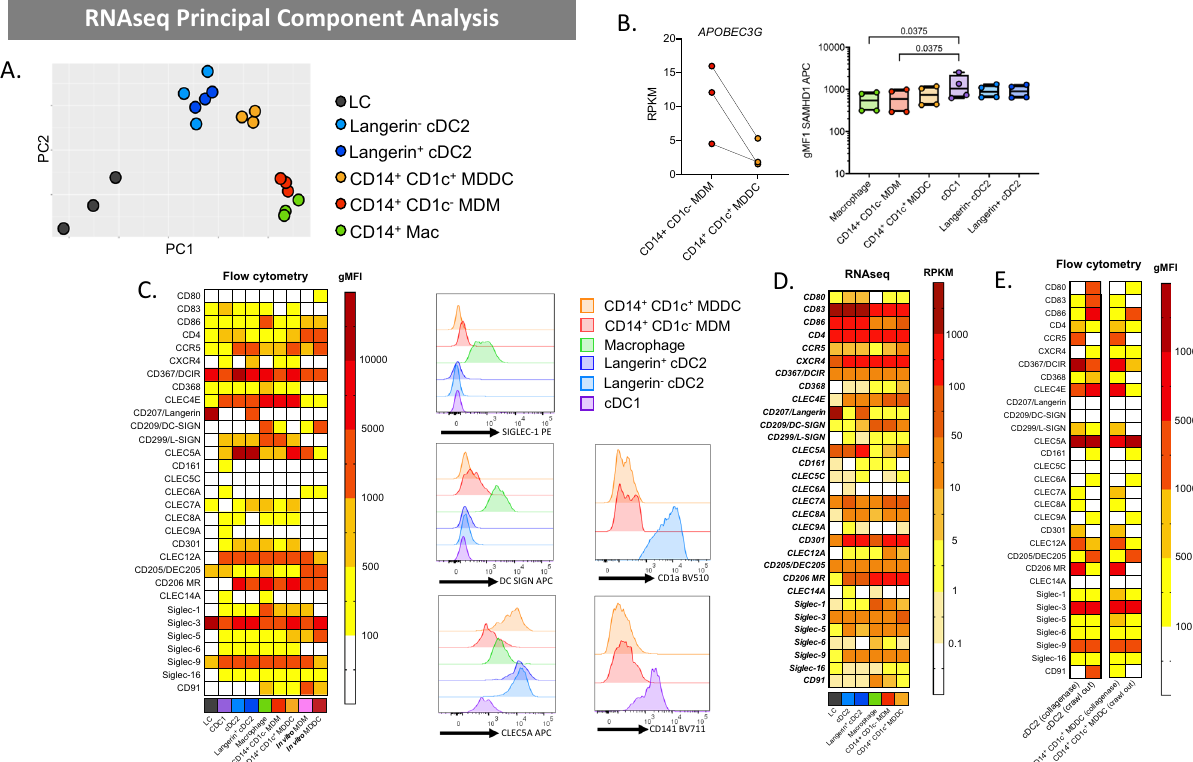
Fig. 3 Genotypic and phenotypic pro fi ling of epidermal and dermal human abdominal skin mononuclear phagocytes. A Dermal macrophages, cDC2 (langerin − and langerin + ), CD14 + CD1c + cells and CD14 + CD1c − cells as well as epidermal Langerhans cells were liberated from n = 3 abdominal skin donors and FACS isolated for RNAsequencing (cDC1 were omitted from analysis due to low donor numbers). A PCA plot shows clustering of cell subsets. B Left: HIV restriction factor APOBEC3G gene expression by RNAseq for CD14 + CD1c − and CD14 + CD1c + cells ( n = 3). Reads per kilobase of transcript, per million mapped reads (RPKM) is plotted with each dot representing an individual donor and lines matching donors. Rights: intracellular SAMHD1 expression on MNP subsets from abdominal skin assessed by fl ow cytometry, plotted as box and whisker plots, box representing the upper and lower quartile, central line representing the median, the whiskers the minimum and maximum of each tissue sample and each donor represented by an individual dot. Statistics generated using Friedman test with two-tailed Dunn ’ s multiple comparisons adjusted P values shown ( n = 5). C Epidermal LCs and dermal MNPs were liberated from tissue using enzymatic digestions and surface receptor expression evaluated by fl ow cytometry and compared to in vitro monocyte-derived macrophages (MDM) and monocyte-derived dendritic cells (MDDC). Left: the geometric mean fl uorescent intensity (gMFI) minus the isotype for each subset was calculated and mean plotted in a heat map ( n = 2 – 11). Right: representative histograms of one donor for cell surface expression of three c-type lectin receptors of interest, Siglec-1, DC-SIGN, CLEC5a for all subsets and CD1a and CD141 expression on CD14 + CD1c − cells and CD14 + CD1c + compared to cDC2 and cDC1 respectively. D A heatmap was also generated from the RNAseq data to investigate the expression of the corresponding genes investigated by fl ow cytometry in C . E Flow cytometry analysis shows differences in cell surface expression on immature (enzymatically digested-derived cells) vs mature (spontaneous migration-derived cells) for left: cDC2 and right: CD14 + CD1c + cells. LC (black), cDC1 (purple), langerin − cDC2 (light blue), langerin + cDC2 (dark blue), dermal macrophages (green), CD14 + CD1c − MDM (red), CD14 + CD1c + MDDC (orange), in vitro MDM (pink) and in vitro MDDC